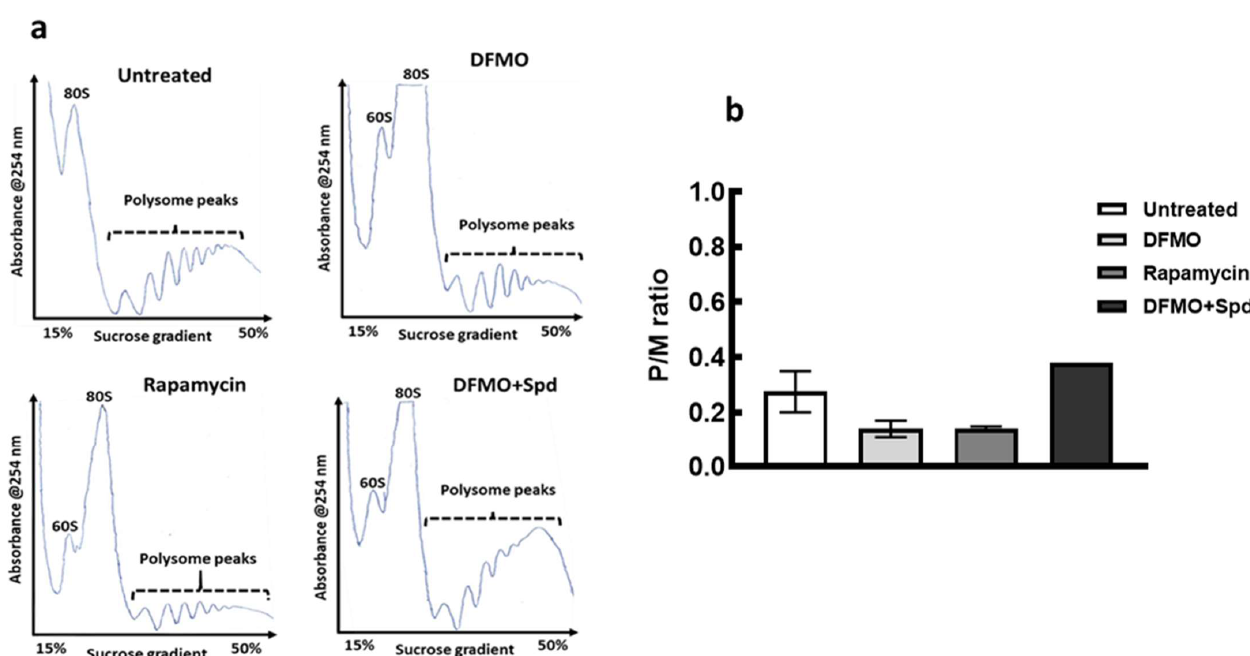
Figure 2. Effects of polyamine modulation on translation initiation of MCF-7 cells . MCF-7 cells were seeded, treated with DFMO for 72 h or DFMO for 48 h plus Spd for 24 h. For rapamycin, cells were treated for 72 h. For the untreated control, cells were seeded and grown for 96 h. All plates were thereafter harvested and processed for polysome analysis. ( a ) is a representative of polysome profiles from untreated control, 5 mM DFMO treatment, 0.1 µM rapamycin and 5 mM DFMO + 100 µM spermidine (Spd) for two independent experiments. ( b ) Estimation of the polysome to monosome ratio for the respective treatment for the area under curve. Values shown are mean ± range, for two independent experiments. For DFMO+Spd, the error bar is within the graph. Similar results were obtained for MDA-MB-231 cell line. Note: rapamy- cin treatment in this figure serves as a positive control of the effect of mTORC1 inhibition in the cancer cells.